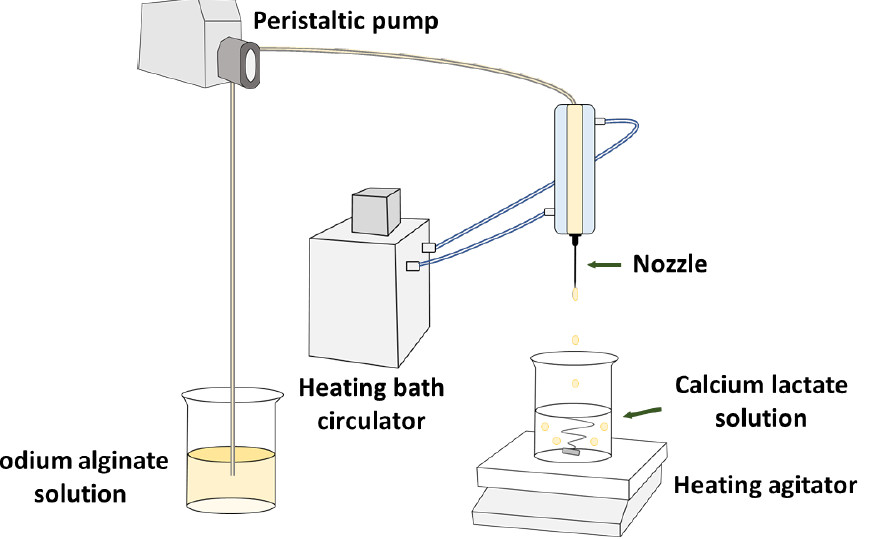
Figure 1. Simple schematic diagram of calcium alginate gel (CAG) bead preparation.